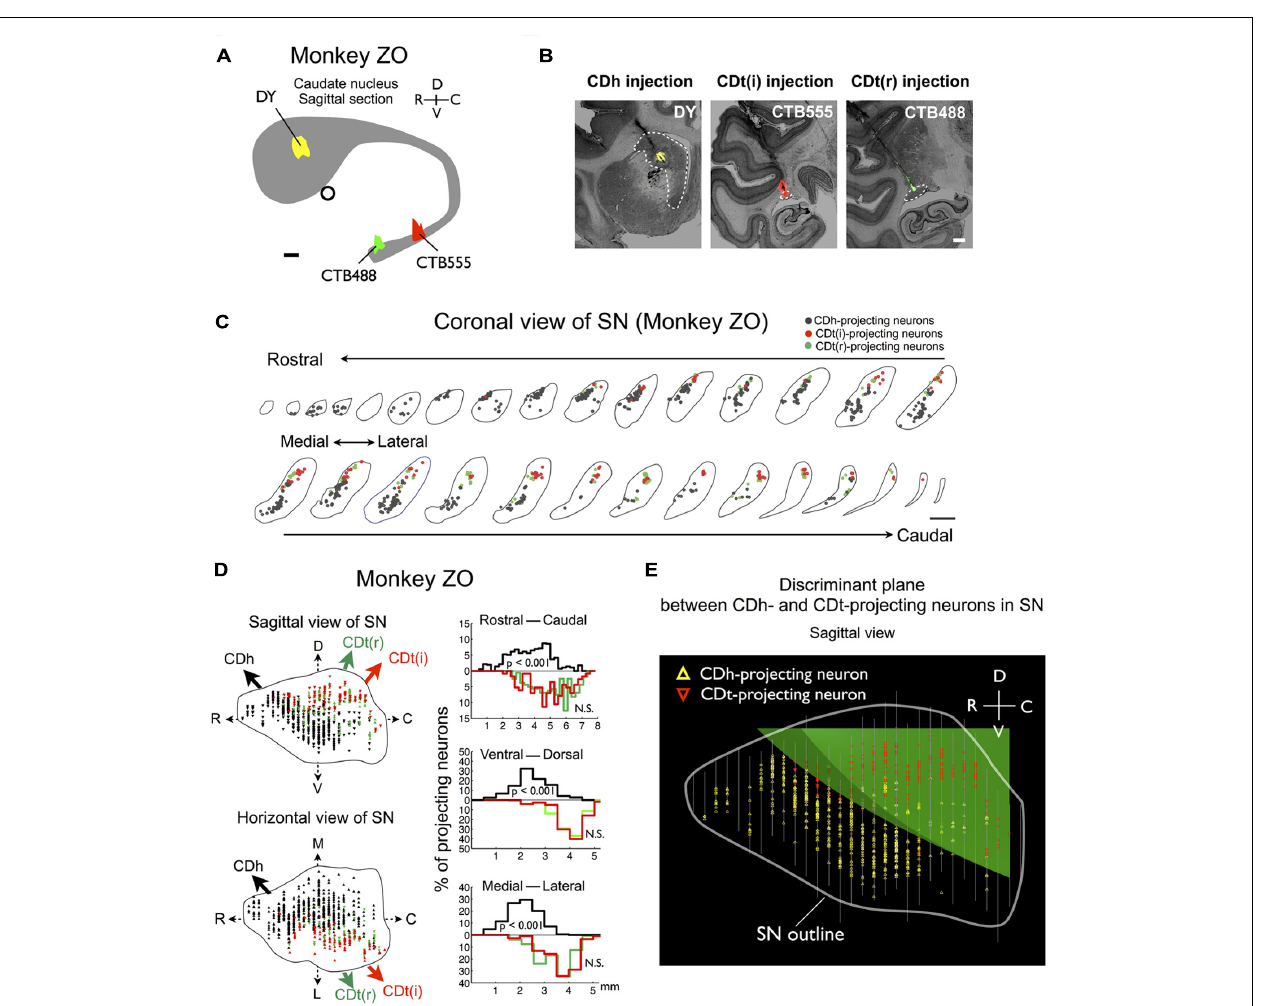
FIGURE 5 | Projections of SNc neurons to CDh and CDt in monkey ZO. Same format as in Figures 3 and 4 .